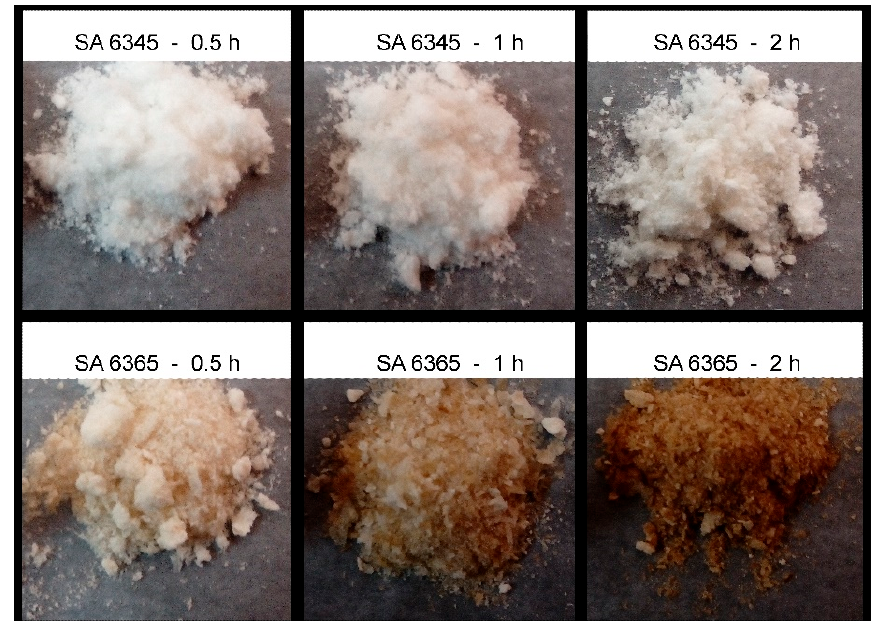
Figure 4. CNCs prepared via different conditions.